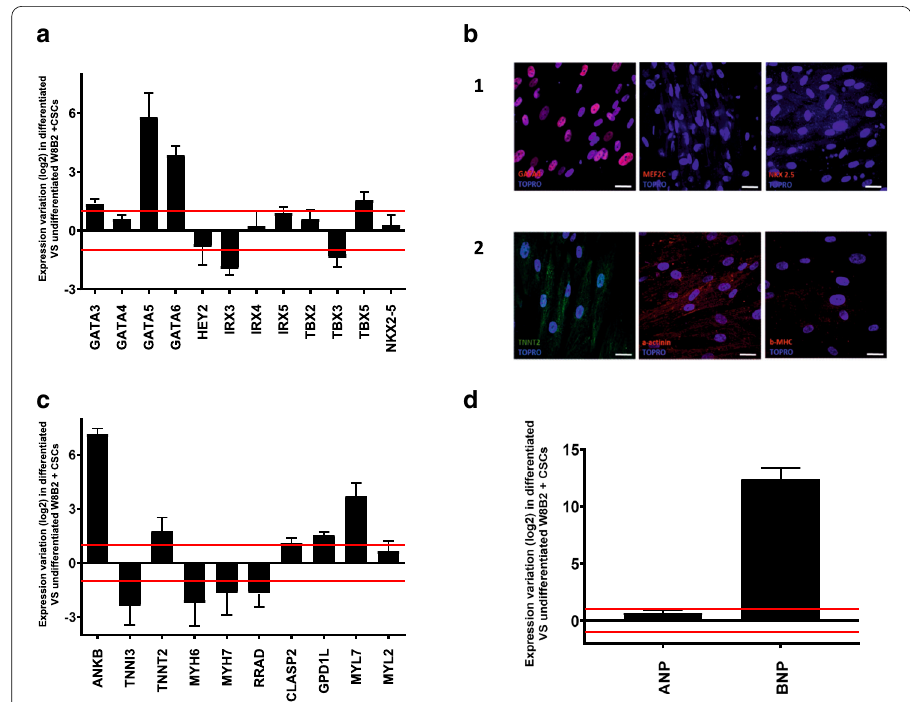
Fig. 1 Effect of W8B2 + CSCs in vitro differentiation on cardiac markers. a Transcript coding for cardiac transcription factors analyzed by TLDA in differentiated vs undifferentiated W8B2 + CSCs. b Determination by immunostaining of protein expression profile of GATA4, MEF2C and NKX 2.5 ( b1 ) and troponin T, a‑actinin and b‑MHC (b2) after in vitro differentiation of W8B2 + CSCs. Nuclei are represented in blue with TOPRO staining. Scale bar 100 μm. c Transcript coding for cardiac contractile structures analyzed by TLDA in differentiated vs undifferentiated W8B2 + CSCs. d Transcript coding for natriuretic peptides [atrial (ANP) and brain (BNP)] analyzed by TLDA in differentiated vs undifferentiated W8B2 + CSCs. The graphs illustrate the gene expression variations (expressed in log 2) of the differentiated cells versus the undifferentiated cells. Values between 1 and 1 (horizontal red lines) indicate that gene expression does not vary (this corresponds to variations − of 2 times and 2 times compared to undifferentiated cells). Each bar represents the mean value + − (standard error of the mean). (N 4 =